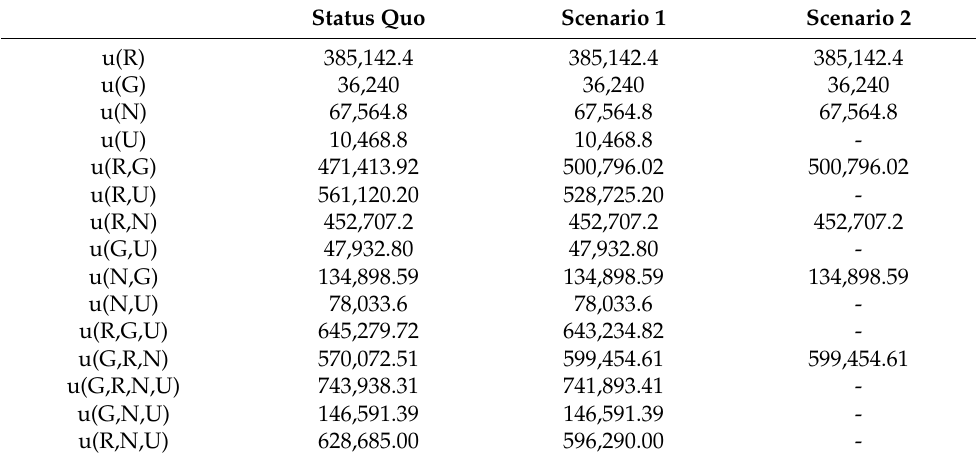
Table A1. Utilities for different